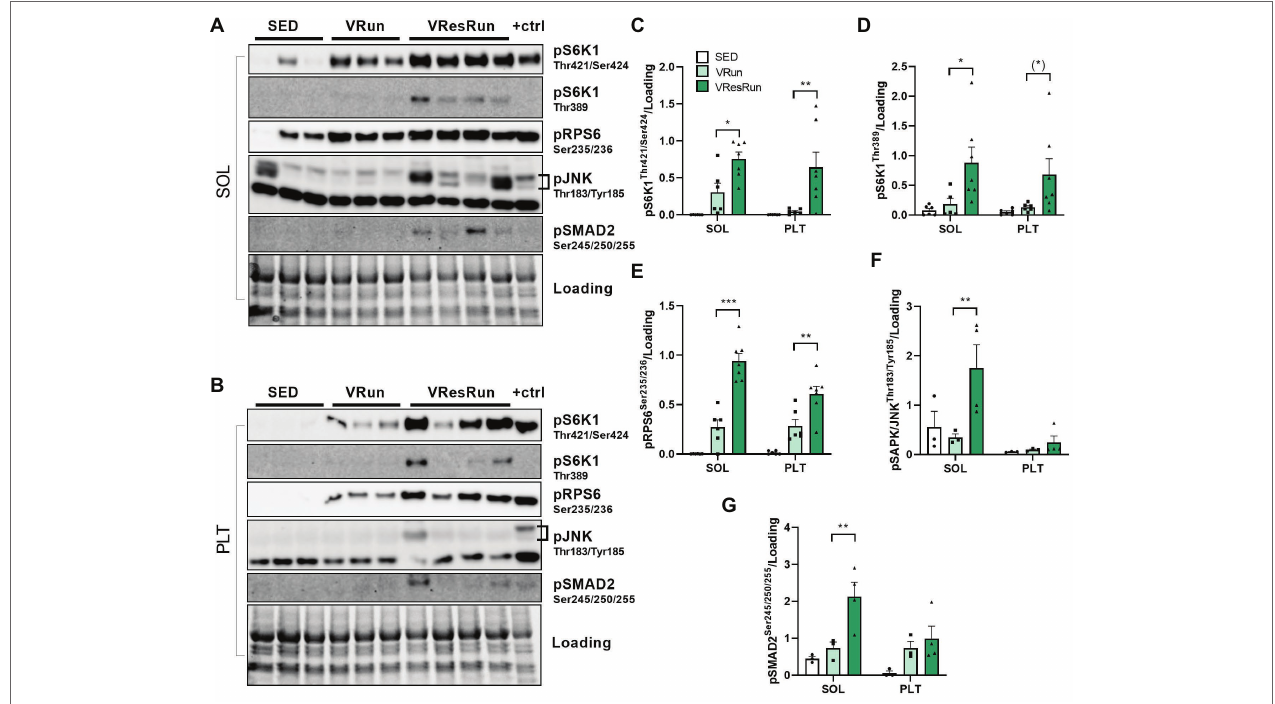
FIGURE 4 | The effect of 5 h of voluntary running (VRun, n = 6) and voluntary resistance running (VResRun, n = 7) on mTORC1 downstream signaling. (A) Representative blots in SOL. (B) Representative blots in PLT. (C) Quantification of pS6K1 Thr421/Ser424 . (D) Quantification of pS6K1 Thr389 . (E) Quantification of pRPS6 Ser235/236 . (F) Quantification of pSAPK/JNK Thr183/Tyr185 . (G) Quantification of pSMAD2 Ser245/250/255 . (Sed, n = 6). * p < 0.05 vs. SED, ** p < 0.01 vs. SED, *** p < 0.001 vs.